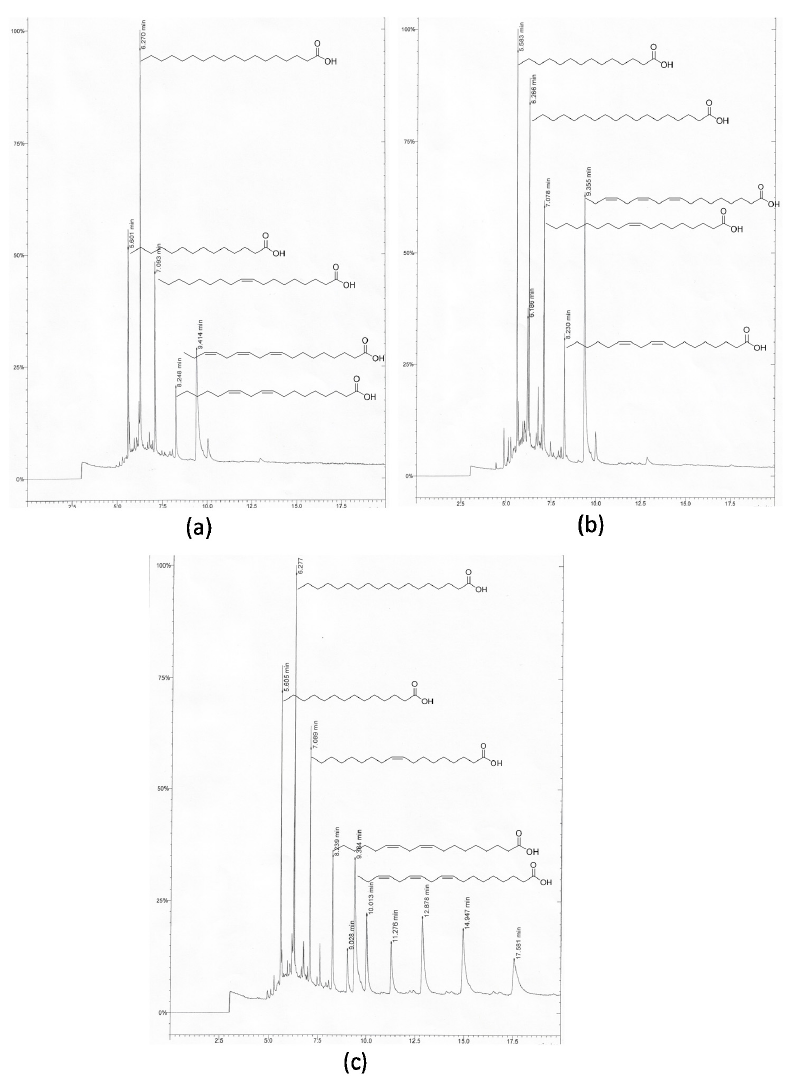
Figure 1. Chromatograms of the lipid profile of the hexane extractions performed in juices: ( a ) control juice; ( b ) pasteurized juice; and ( c ) thermoultrasonicated juice.